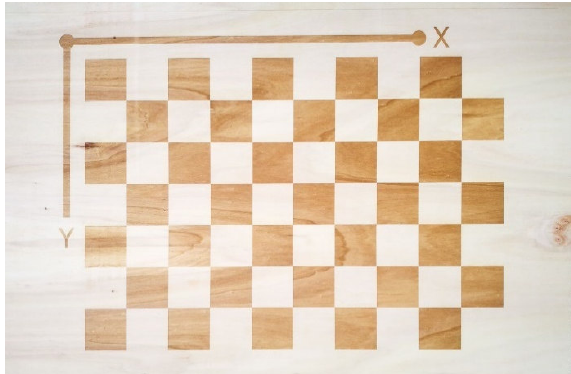
Figure 6. The checkerboard panel with the laser engraved pattern used by the Camera Calibrator app.